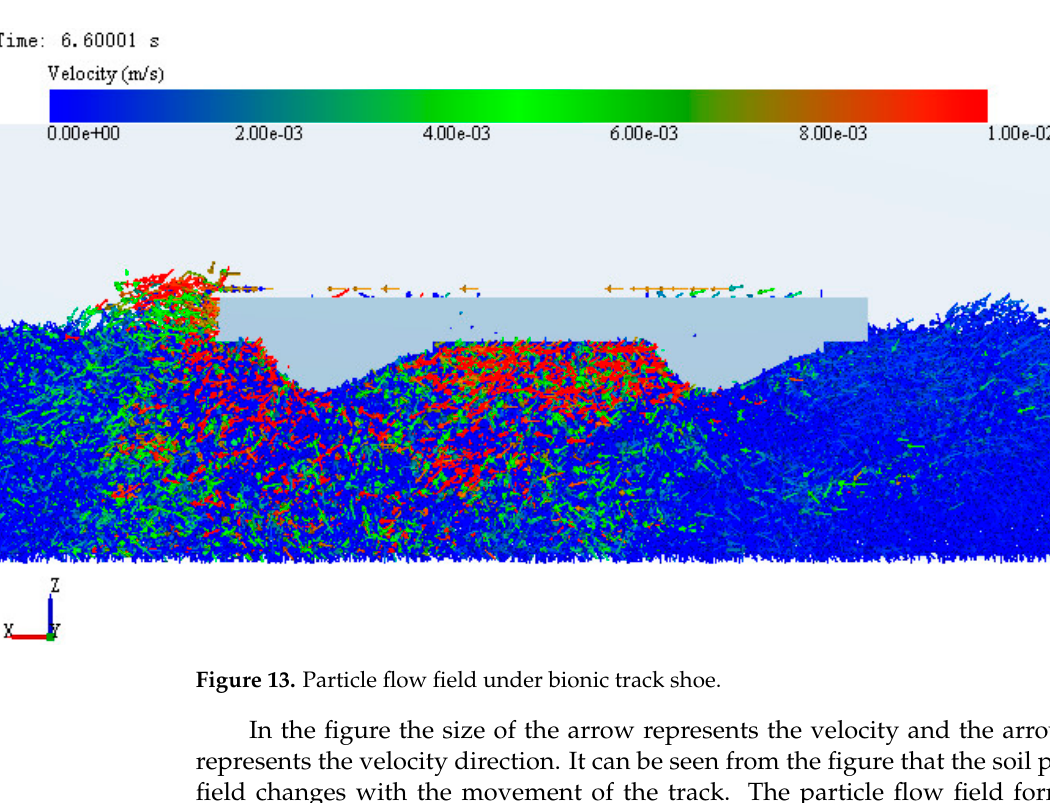
Figure 12. Particle flow field under ordinary track shoe.